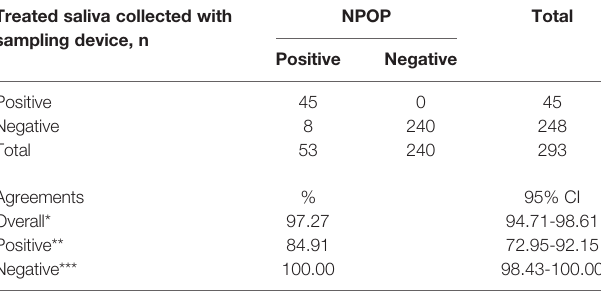
TABLE 4 | Implementation of a sampling device and treatment method for saliva specimens. Treated saliva collected with sampling device,